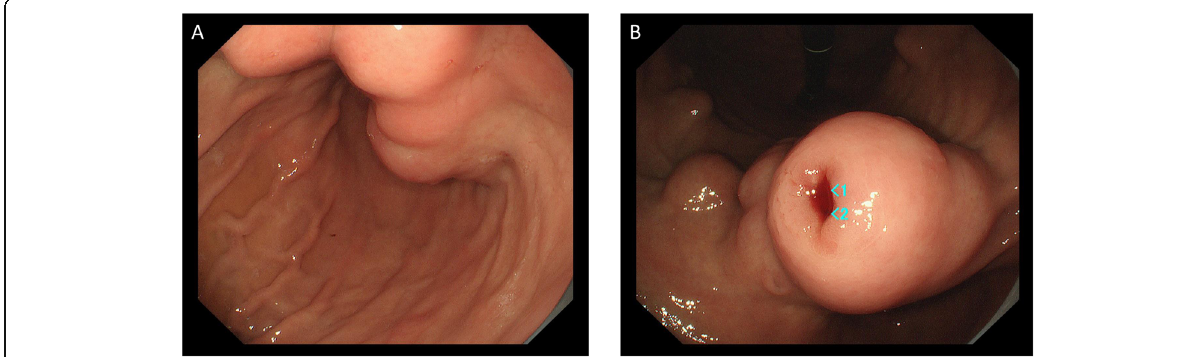
Fig. 4 a Endoscopic examination of the upper gastrointestinal tract showing the presence of multiple submucosal tumors on the residual side of the lesser curvature. b Biopsy of the tumor confirmed the pathological diagnosis of